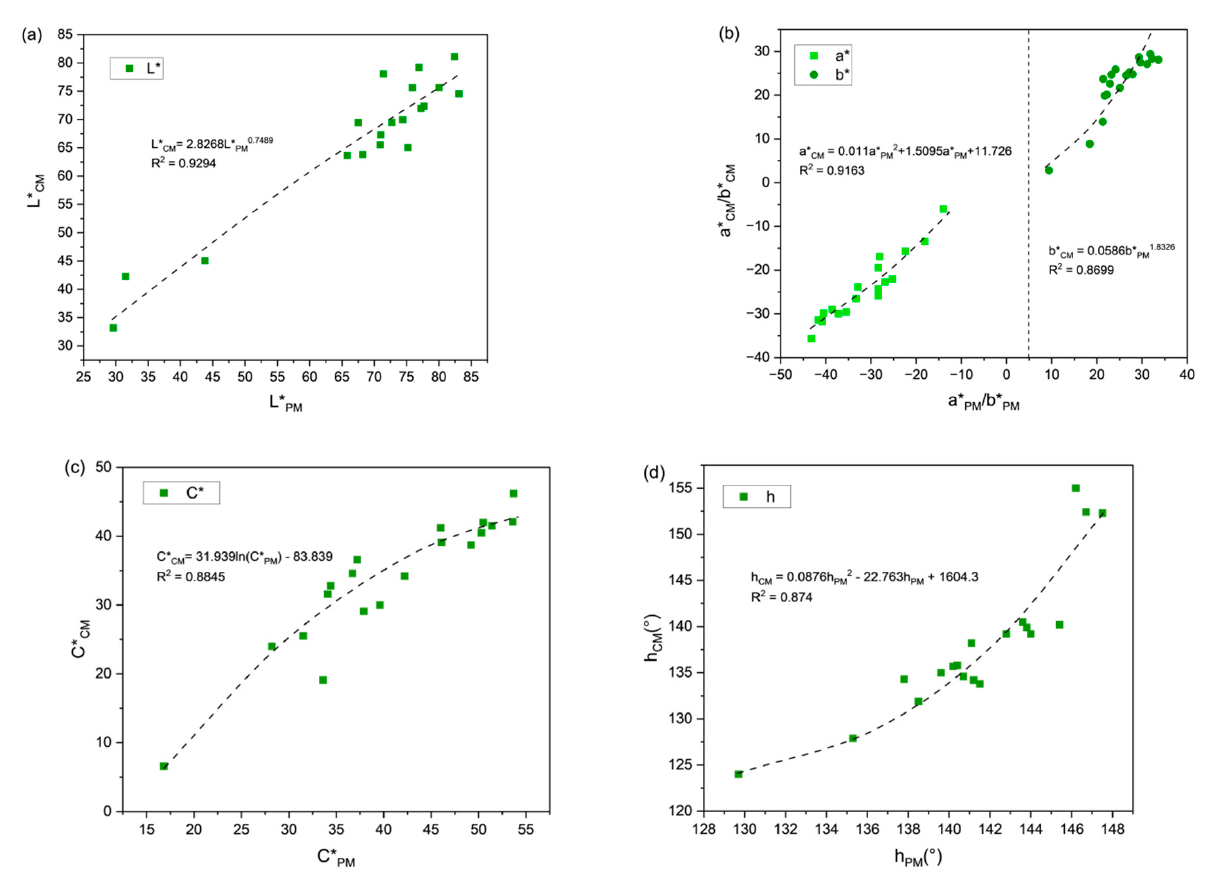
Figure 8. Regression curve for L*, a*, b*, C*, and h*: ( a ) L* CM − L* PM ; ( b ) a* CM − a* PM and b* CM − b* PM ; ( c ) C* CM − C* PM ; ( d ) h* CM − h* PM .